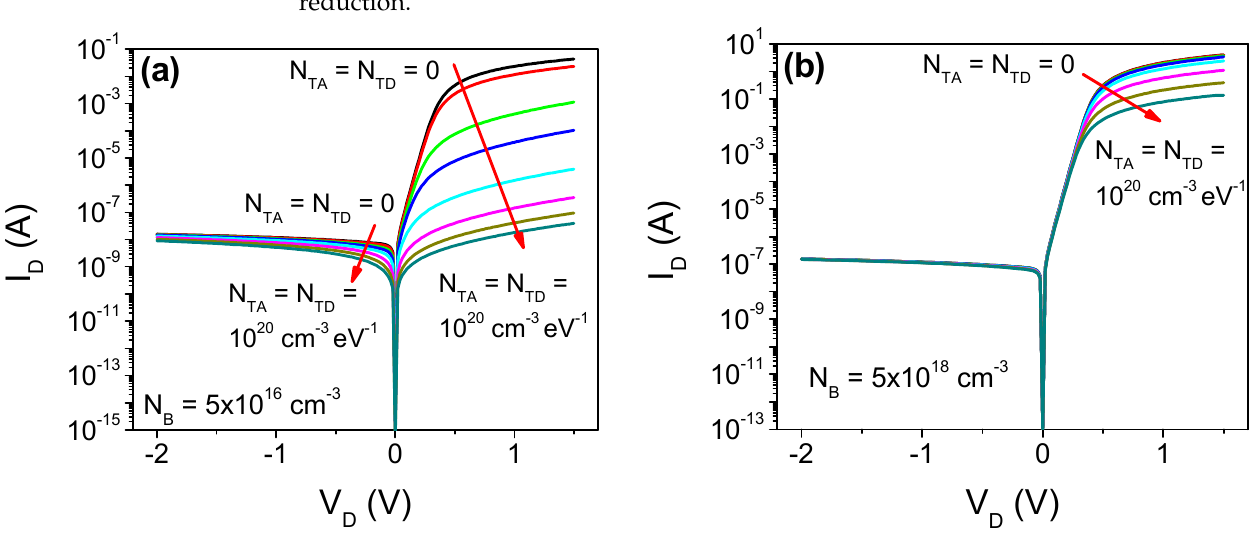
Figure 5. I – V characteristic for the simulated SBD considering different densities of localized states for N B equal to ( a ) 5 × 10 16 and ( b ) 5 × 10 18 cm − 3 . For comparison, defect free devices ( N TA = N TD = 0) are considered.